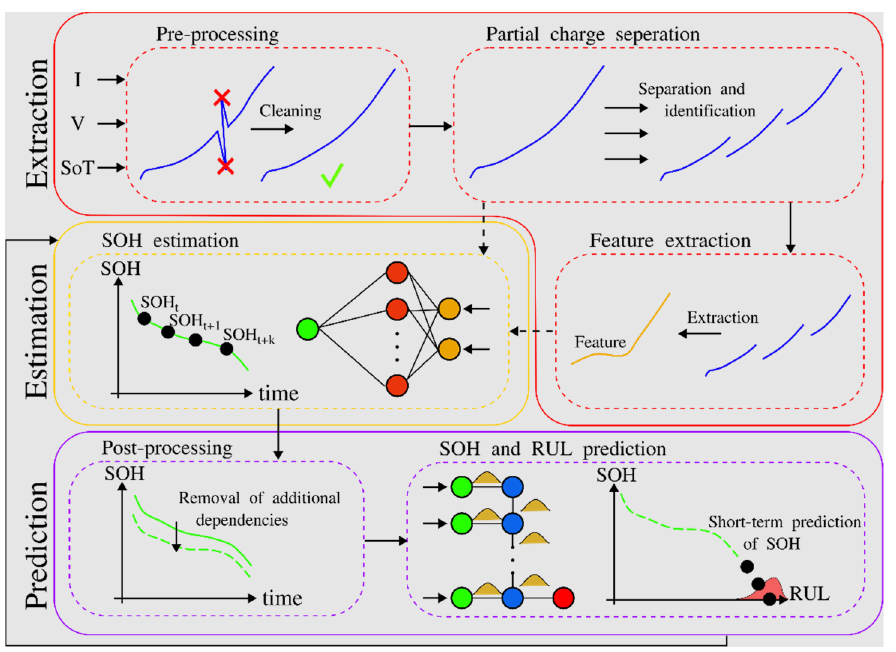
Figure 8. A flowchart of the Smart Battery SOH and RUL prediction framework. In order to stabilize the predictions of the SOH, the time dependence of the system is moved from the SOH to the features. To predict the SOH, the features are predicted forward in time, and a SOH estimation model is then used to predict the